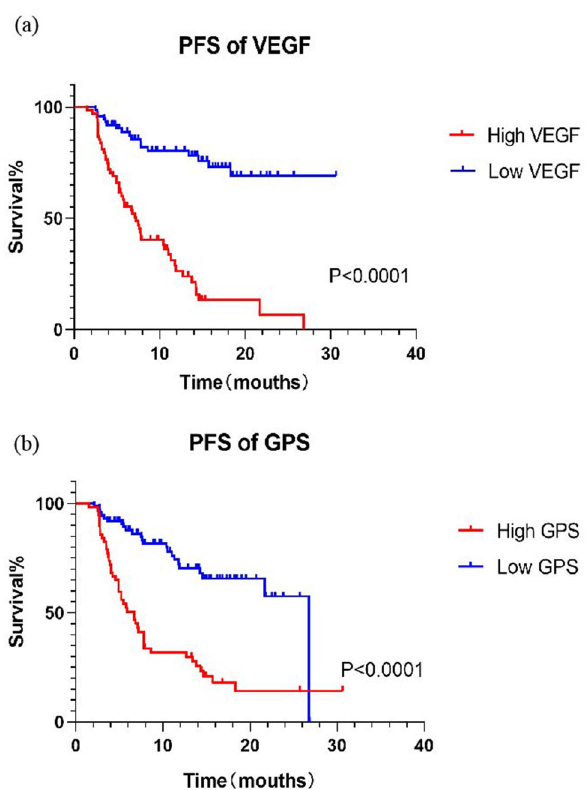
Figure 6. Kaplan–Meier analysis on different VEGF/GPS groups (high and low) of all enrolled patients. ( a ) The high VEGF group was significantly associated compared to low VEGF group with poor prognosis (p < 0.0001) of patients. ( b ) The high GPS group was significantly associated compared to low GPS group with poor prognosis (p < 0.0001) of